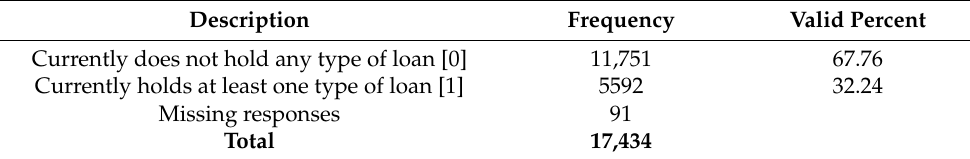
Table 2. Detail of the combined variable “debt-taking behaviour” (wave 18).